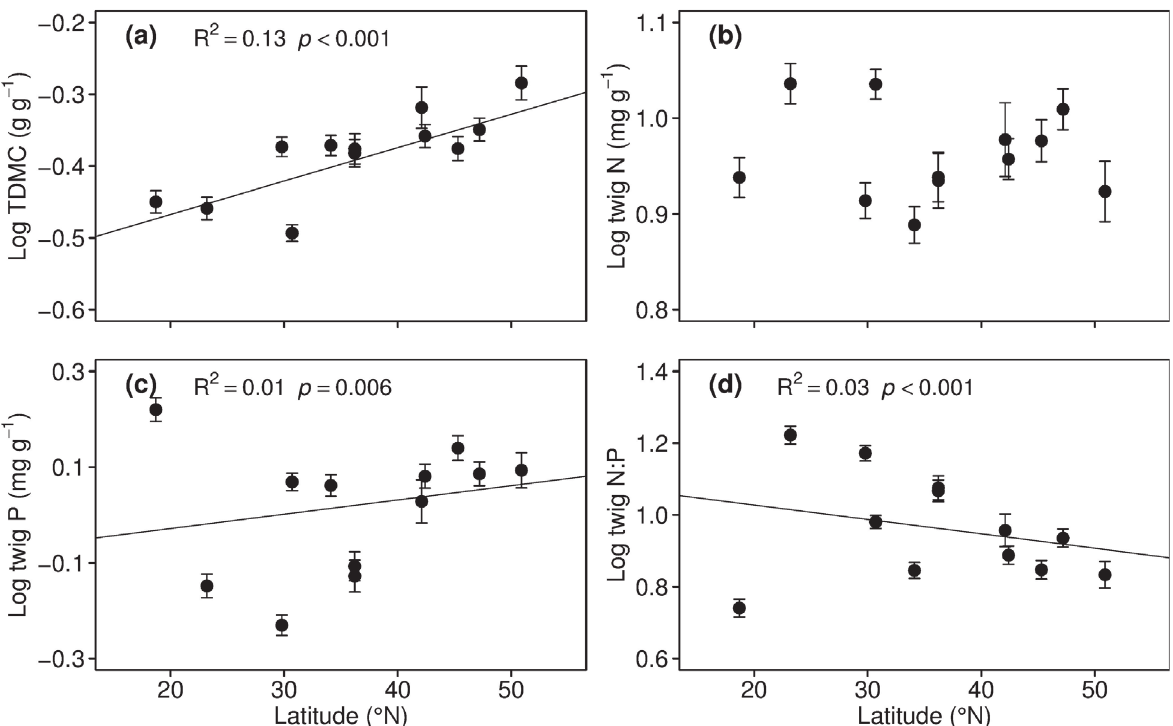
Figure 2. Changes in site-averaged dry matter content (TDMC) and C, N, and P content of twigs with latitude. (a) TDMC, (b) N content, (c) P content, and (d) N:P ratio. Regression lines are fit to the raw data with p < 0.05. Points and error bars stand for the means and standard errors of the twig